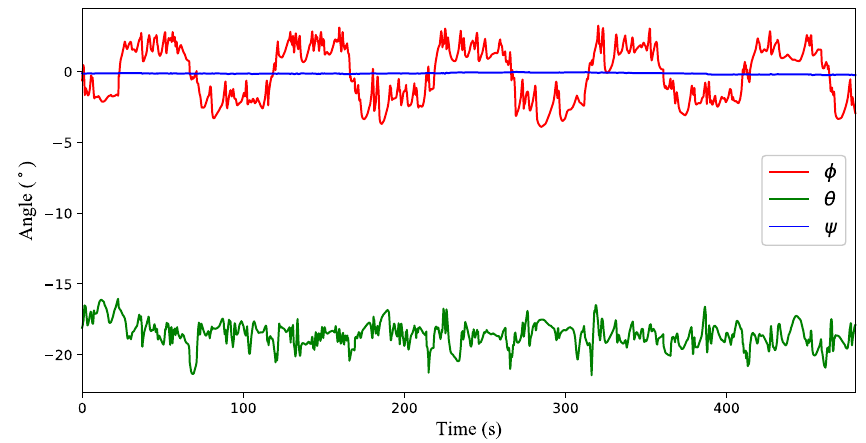
Figure 11. Attitude variation of the quadrotor flying in the time-varying wind field.